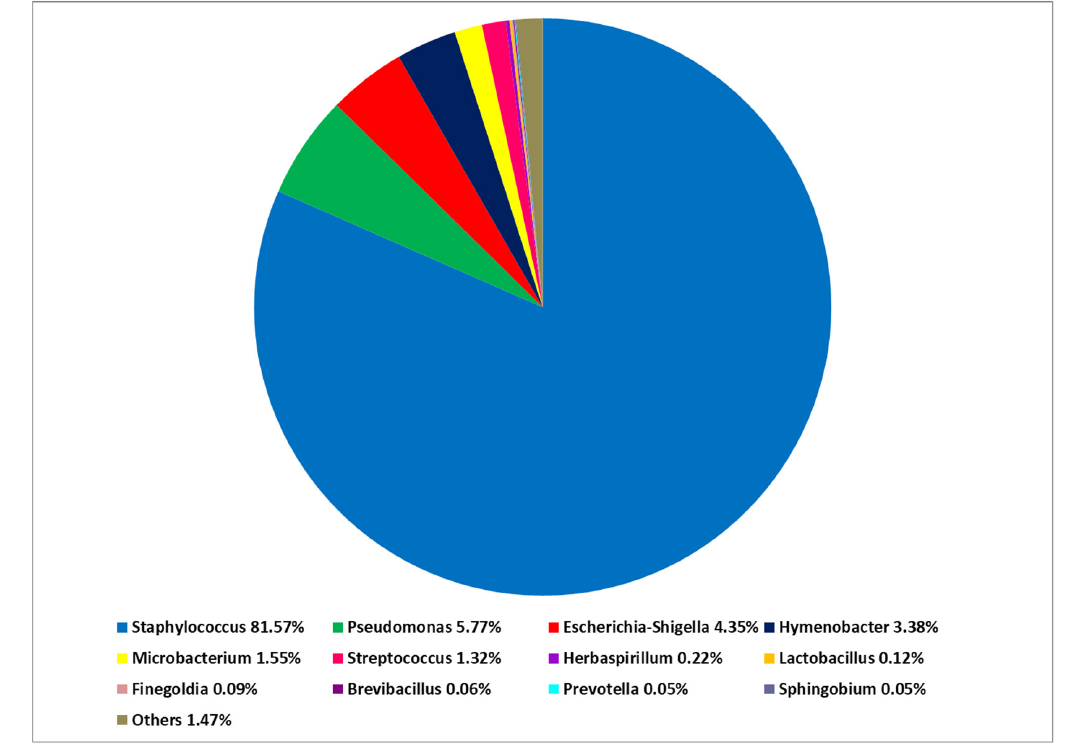
Figure 2. Total composition of cutaneous bacteria microbiome at the genus level in patients with prurigo nodularis (PN).